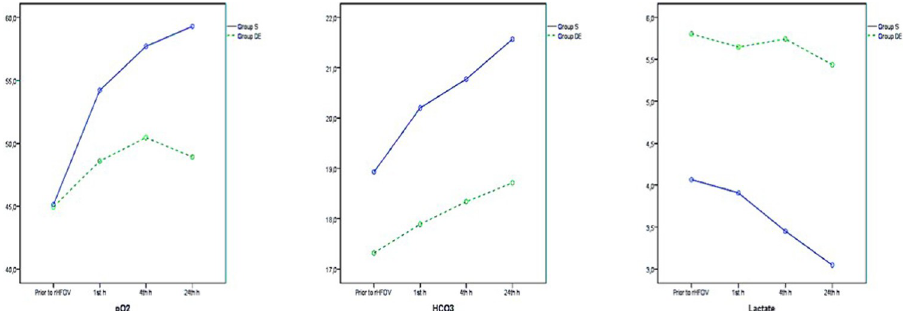
Fig 3. 3A, 3B and 3C. Changes in pO 2 , HCO 3 and